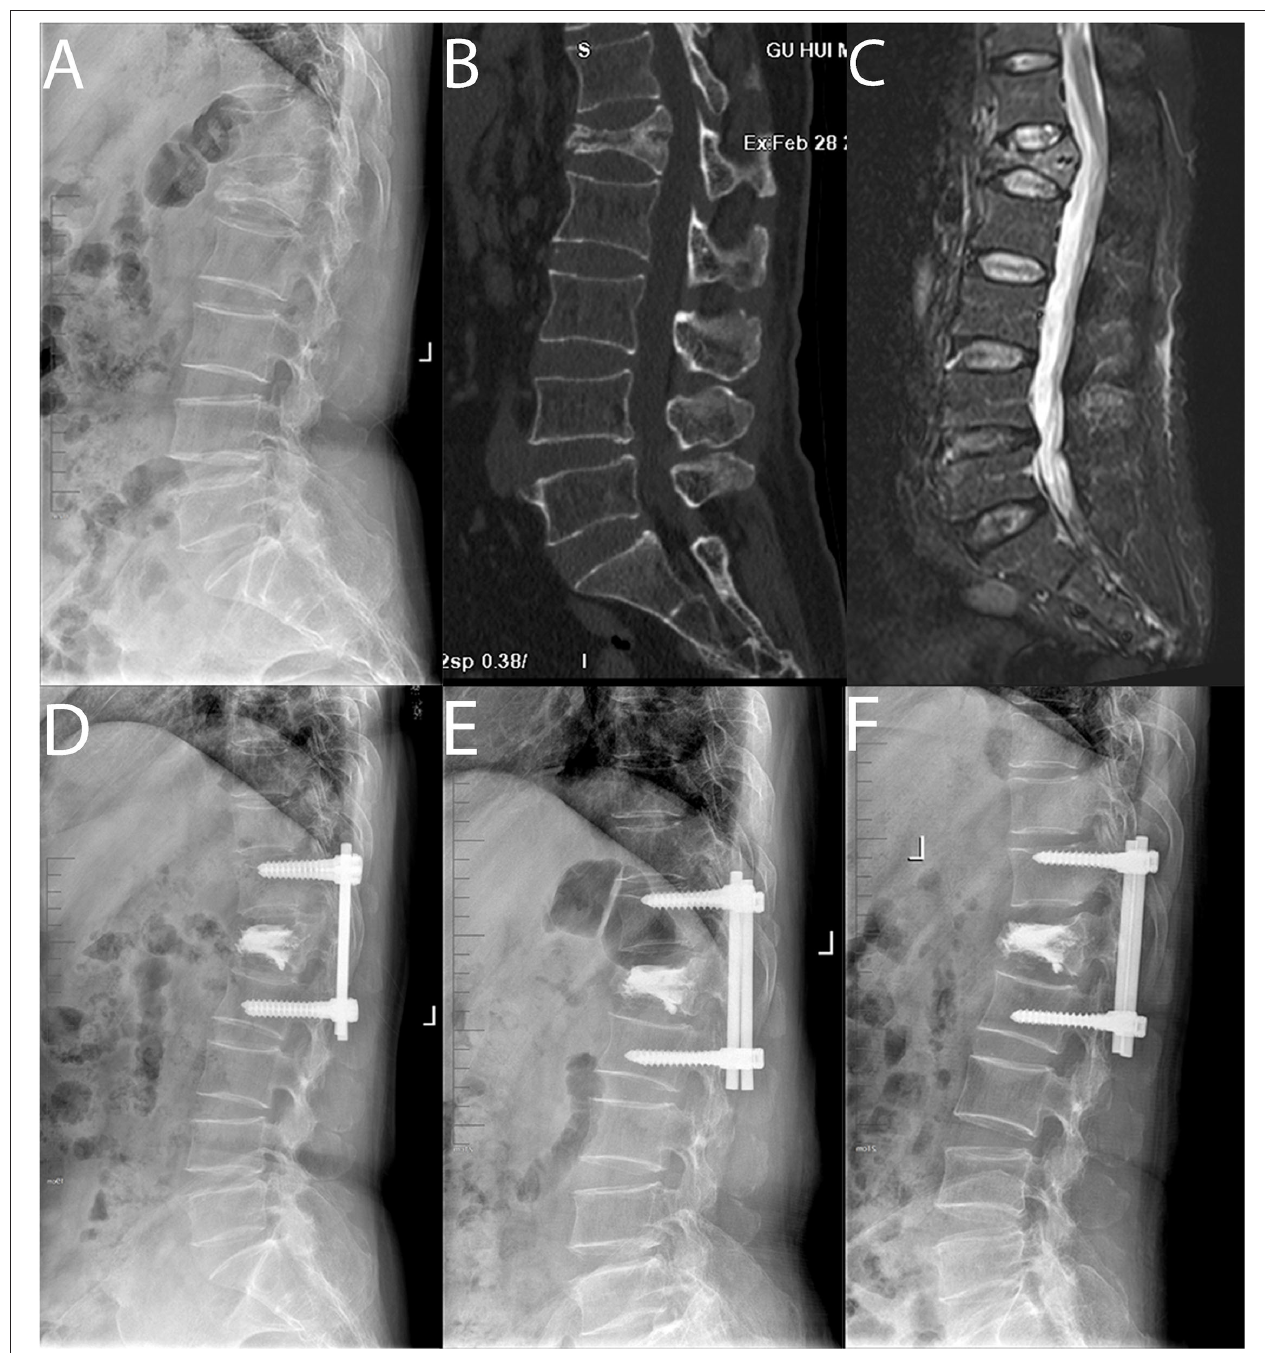
FIGURE 2 | Pre-operative sagittal lateral view (A) , sagittal computed tomographic scan (B) , sagittal fat-suppressed sequence in MRI (C) , post-operative sagittal lateral view (D) , sagittal lateral view 1 month after surgery (E) and sagittal lateral view at the final follow-up (F) of a 62-year-old male patient with L1 sOVCF was treated with PPSF +